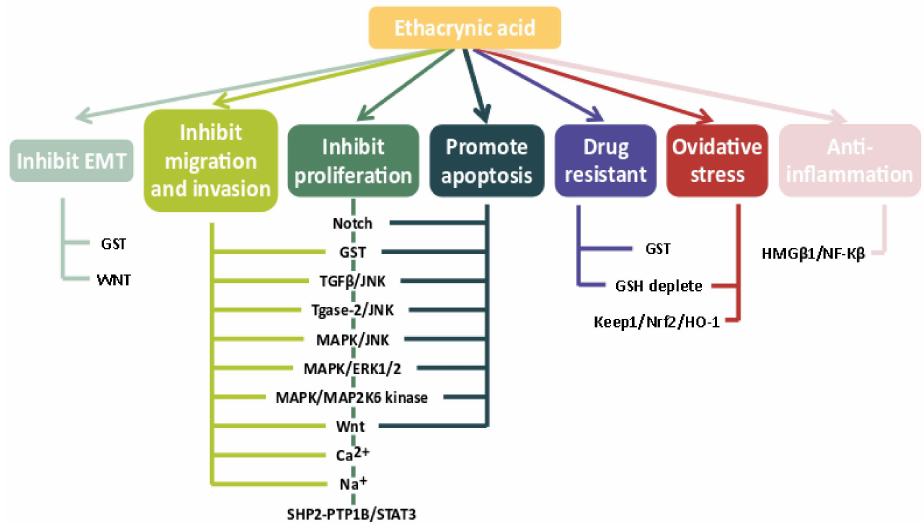
Figure 3. Effect and mechanism of ECA on cancer